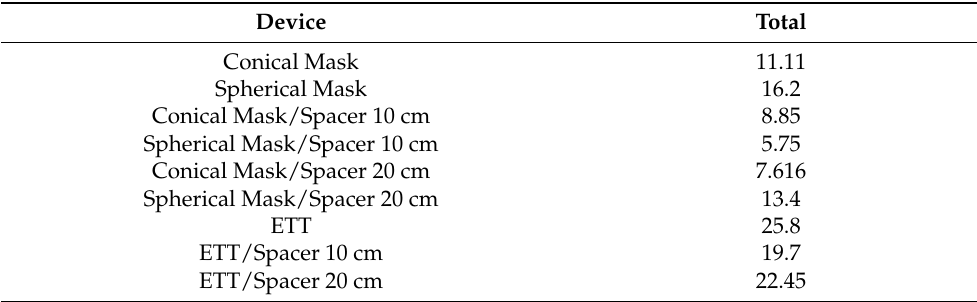
Table 2. Percentage of particles reaching the lung after 7 respiratory cycles (I:E ratio 1:2, inspiratory time 1 s).